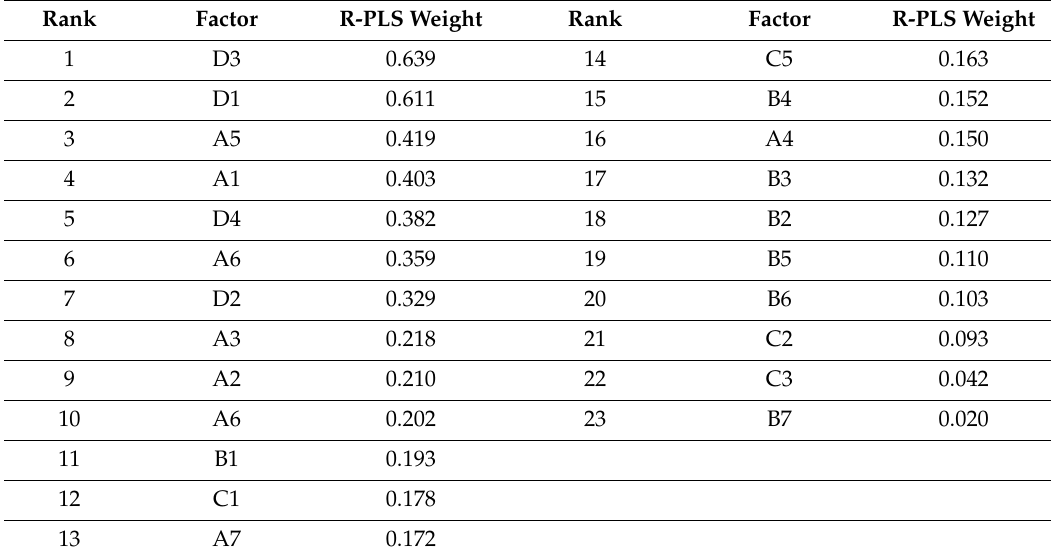
Table 9. Robustness check (robust partial least squares (R-PLS)